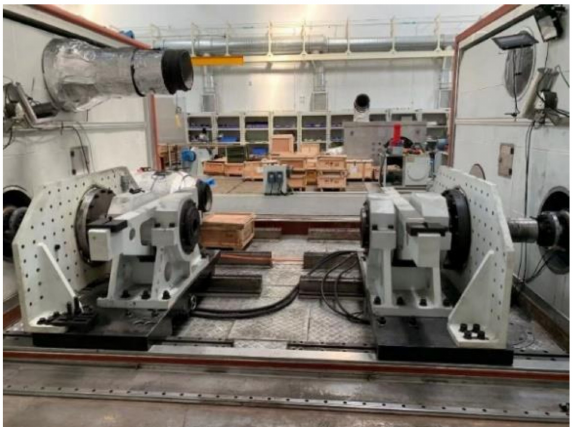
Figure 2. High-efficiency Braking System Performance Test Bench.